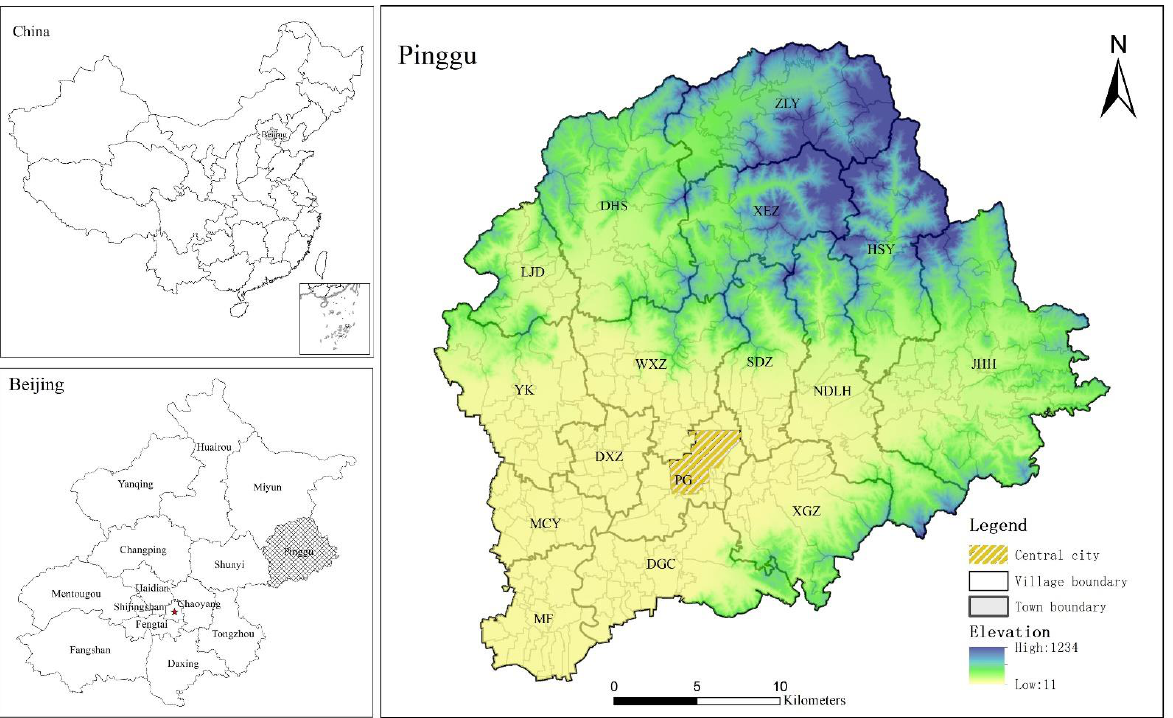
Figure 1. Study area (the abbreviations of the townships are as follows: PG (Pinggu), DXZ (Dax- ingzhuang), DGC (Donggaocun), MCY (Machangying), WXZ (Wangxinzhuang), XGZ (Xiagezhuang), MF (Mafang), YK (Yukou), SDZ (Shandongzhuang), JHH (Jinhaihu), LJD (Liujiadian), NDLH (Nandulehe), DHS (Dahuashan), XEZ (Xiongerzhai), ZLY (Zhenluoying), and HSY (Huangsongyu)).